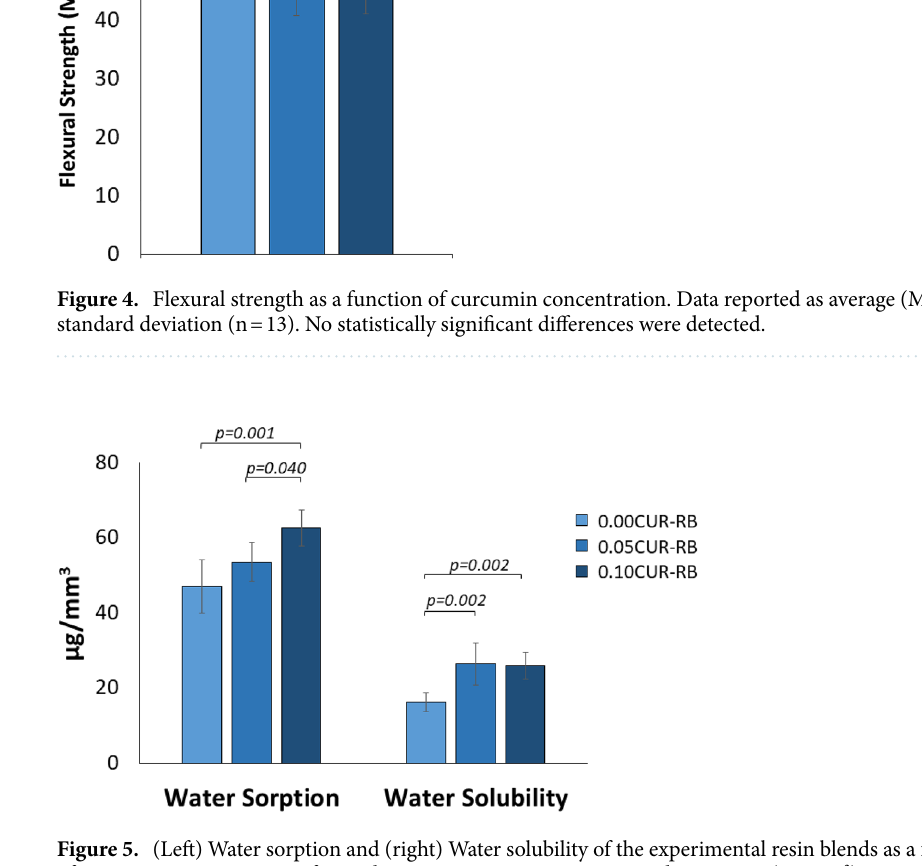
Figure 5. (Left) Water sorption and (right) Water solubility of the experimental resin blends as a function of curcumin concentration after 14d in 37 °C water. Data is presented as average (µg/mm 3 ) ± one standard deviation (n = 6). Horizontal bars indicate statistically detectable difference (p <